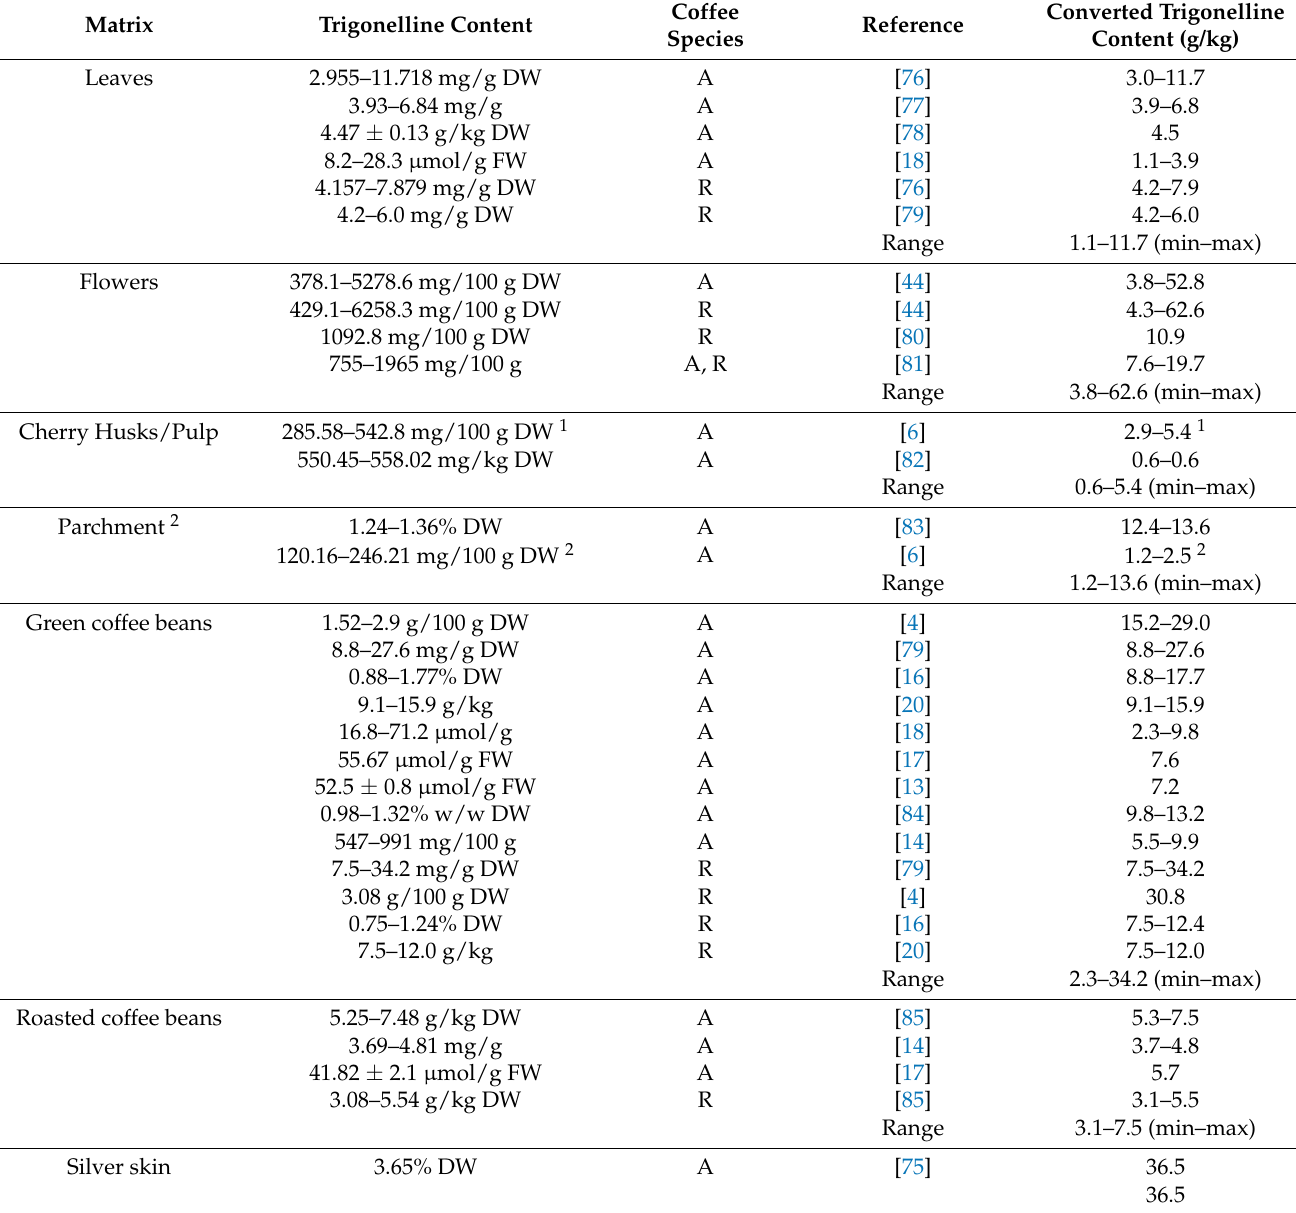
Table 2. Trigonelline contents of coffee and coffee by-products of C. arabica and C. canephora